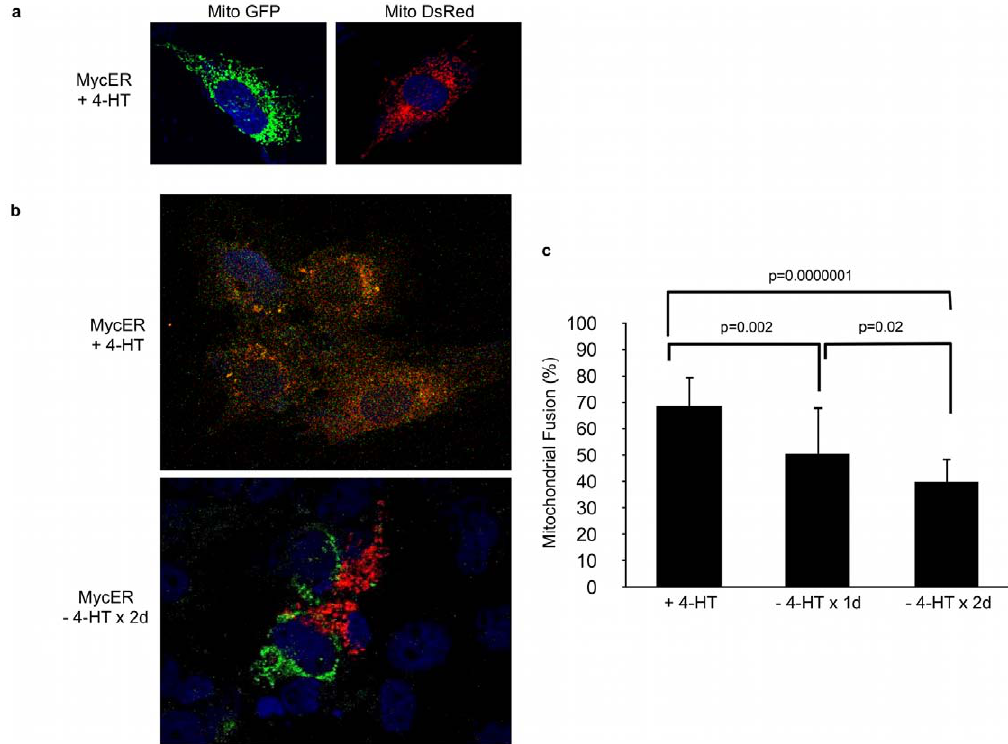
Figure 7. PEG Fusion Assay. ( a ) MycER cells exposed to 4-HT chronically were stably transduced with lentiviruses encoding mitochondrially targeted DsRed or GFP. Photos show representative cells with mitochondrially-targeted fluorescent proteins. ( b ). Cells were co-plated in the presence or absence of 4-HT and were treated with PEG following incubation with CHX. Cells were fixed stained with DAPI and heterokaryons were identified and imaged by confocal fluorescent microscopy. ( c ) The degree of mitochondrial fusion was calculated by determining the percentage of co-localized fluorescent signals with the use of the CoLocalizer Pro software package. Cells from which 4-HT was removed from the media for one or two days were compared to cells constantly maintained in